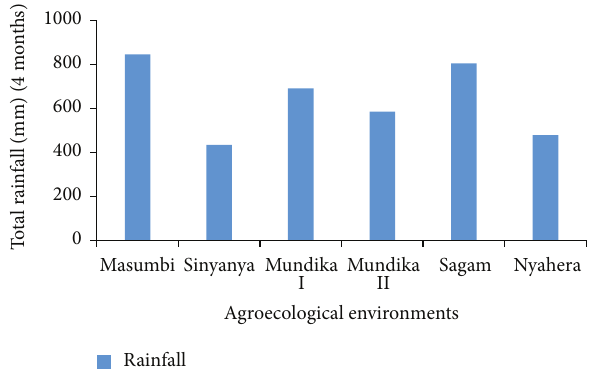
Figure 2: Cumulative rainfall during sorghum growing period.